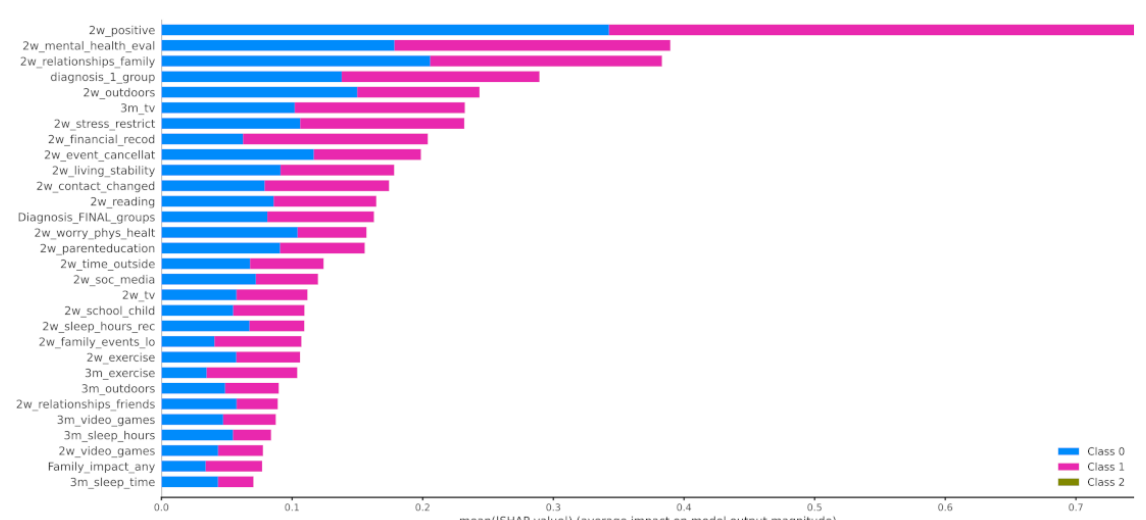
Figure 16. Mean SHAP values of patients from class 0 and class